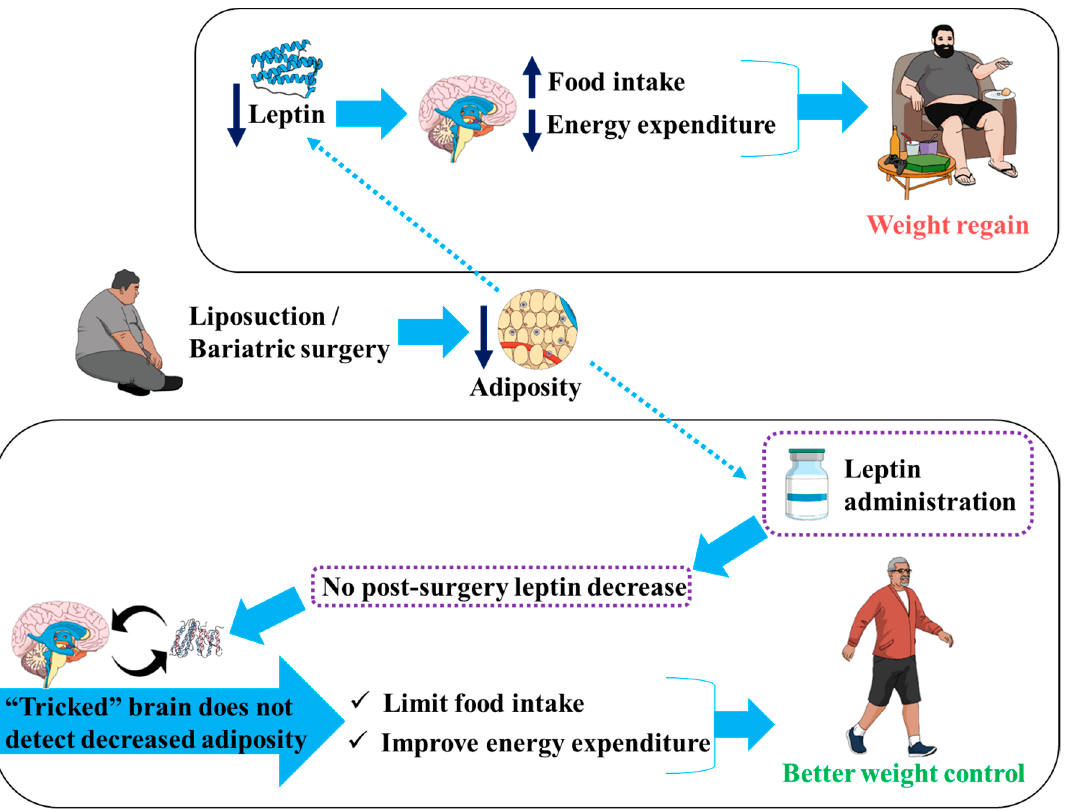
Figure 1. Administering leptin could trick the brain so that it does not detect the post- liposuc- tion/bariatric surgery weight loss and, thus, limit the signals that are toward weight regain.